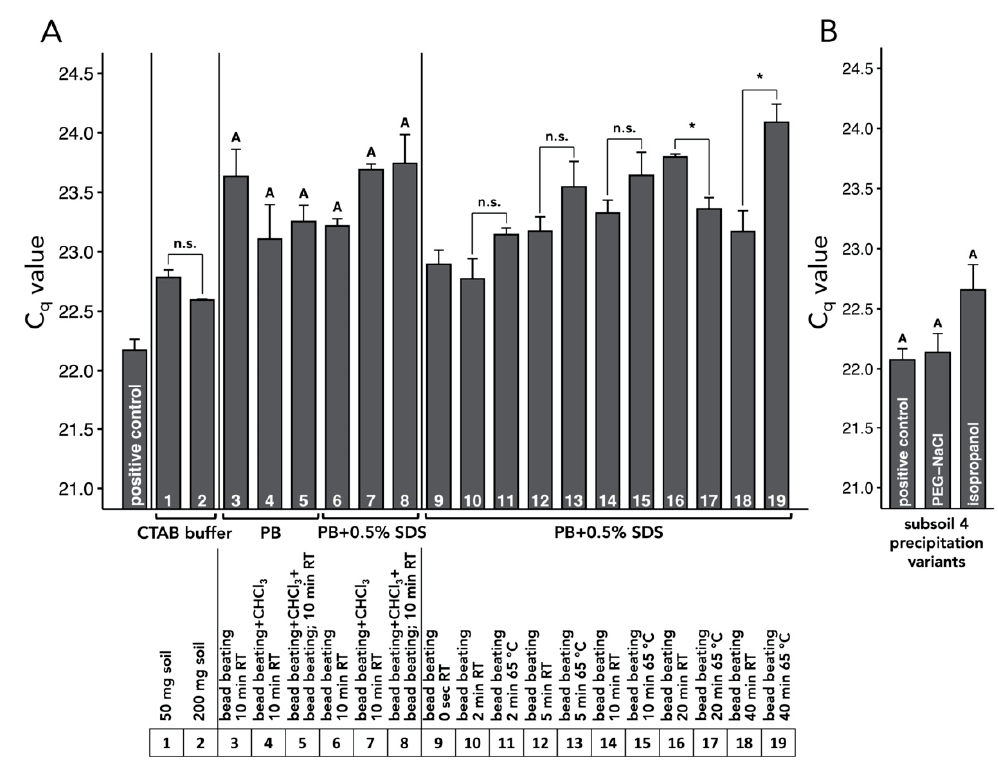
Figure 4. DNA amplification inhibition test of DNA extracts from subsoil using different extraction methods (see 2.4. DNA amplification inhibition test for methodological details) ( A ) and subsoil 4 using polyethylene glycol (PEG) ‐ NaCl and isopropanol precipitation ( B ). Differences between two groups of samples (e.g., 1 and 2 or 10 and 11) were tested using student’s t ‐ test (* p < 0.05). Differences among more than two groups of samples (e.g., 3 to 8) were tested using ANOVA with Tukey HSD. Different uppercase letters indicate statistically significant differences at p < 0.05. C q = quantification cycle; n.s. = no statistically significant differences; CTAB = cetyltrimethylammonium bromide; PB = phosphate buffer; RT = room temperature; SDS = sodium dodecyl sulfate.